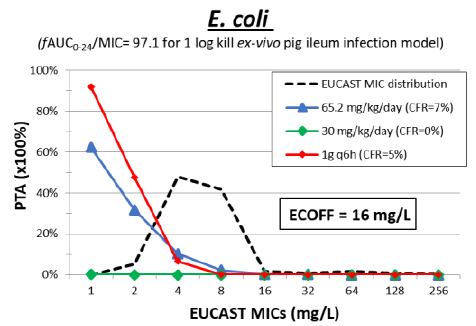
Figure 8. Probability of target attainment (PTA) of chloramphenicol at different dosing regimens against isolates with increasing MIC. The cumulative fraction of response (CFR) is shown for a collection of isolates with the EUCAST MIC distribution.